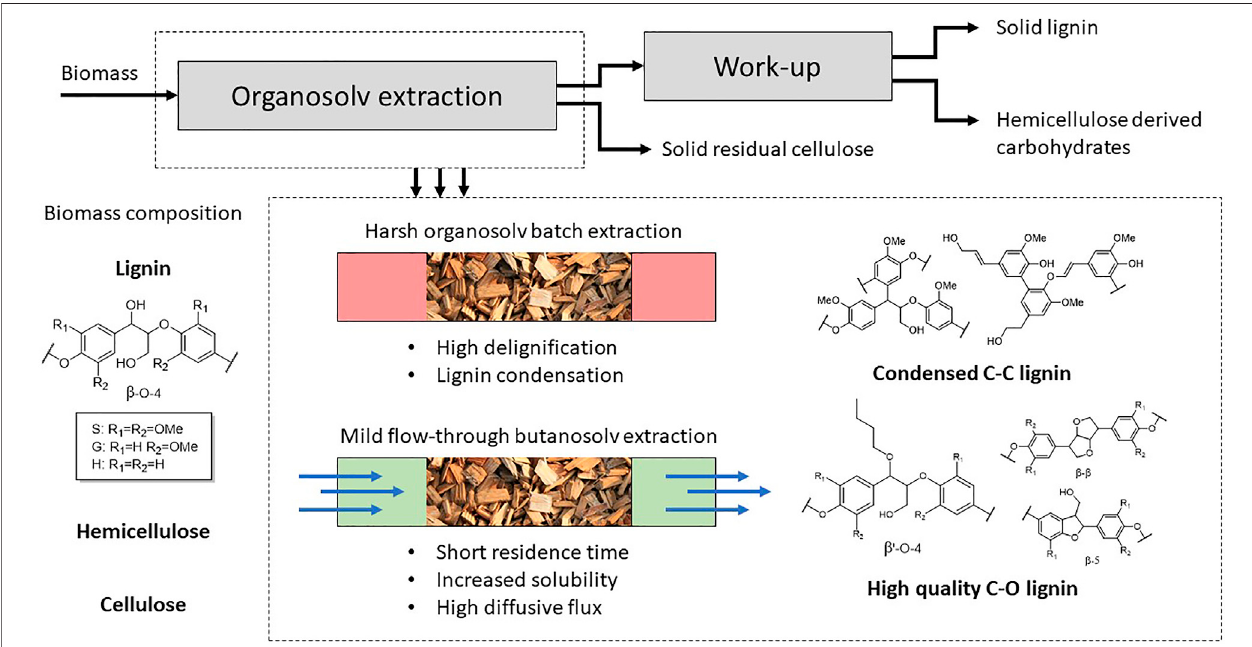
FIGURE 1 | Schematic overview of mild organosolv fractionation of biomass and the in fl uence of the extraction conditions.